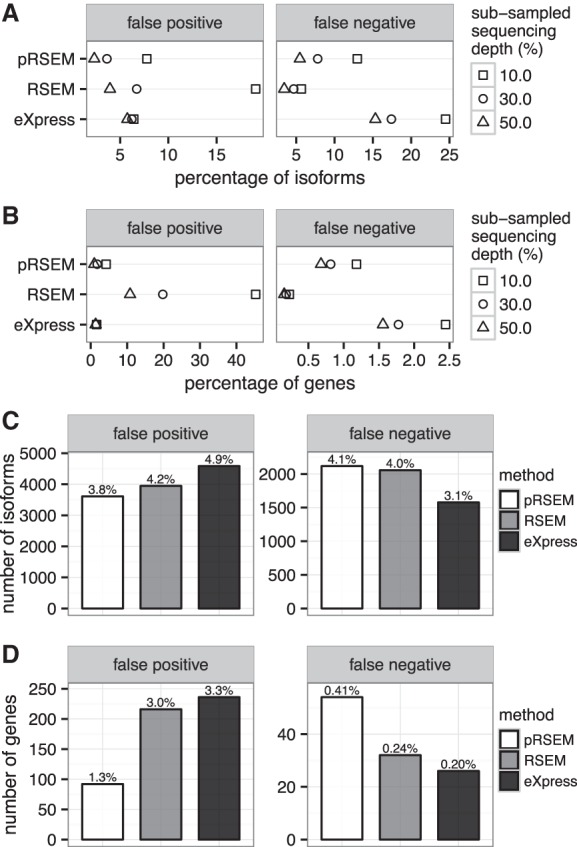
Data-driven simulations reveal that pRSEM has a lower false-positive rate (FPR) than RSEM and eXpress. (A,B) Shape plots (squares, circles, triangles) represent FPR and false negative rate (FNR) for isoforms (A) and genes (B) in subsampling experiments. (C,D) Bar plots show the number of isoforms (C) and genes (D) classified as false positives and false negatives from simulations at full sequencing depth. FPR and FNR are shown above each bar. A false positive is an isoform or gene with a true abundance <1 TPM and an estimated abundance ≥1 TPM. A false negative is an isoform or gene with a true abundance ≥1 TPM and an estimated abundance <1 TPM.